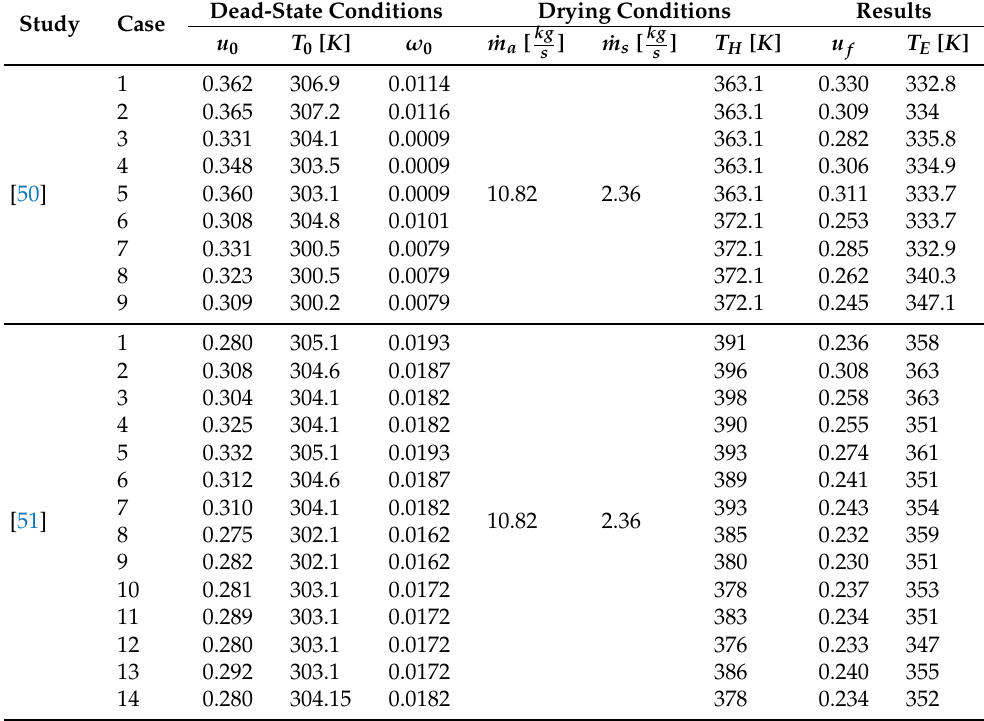
Table A3. The validation cases of the reference drying